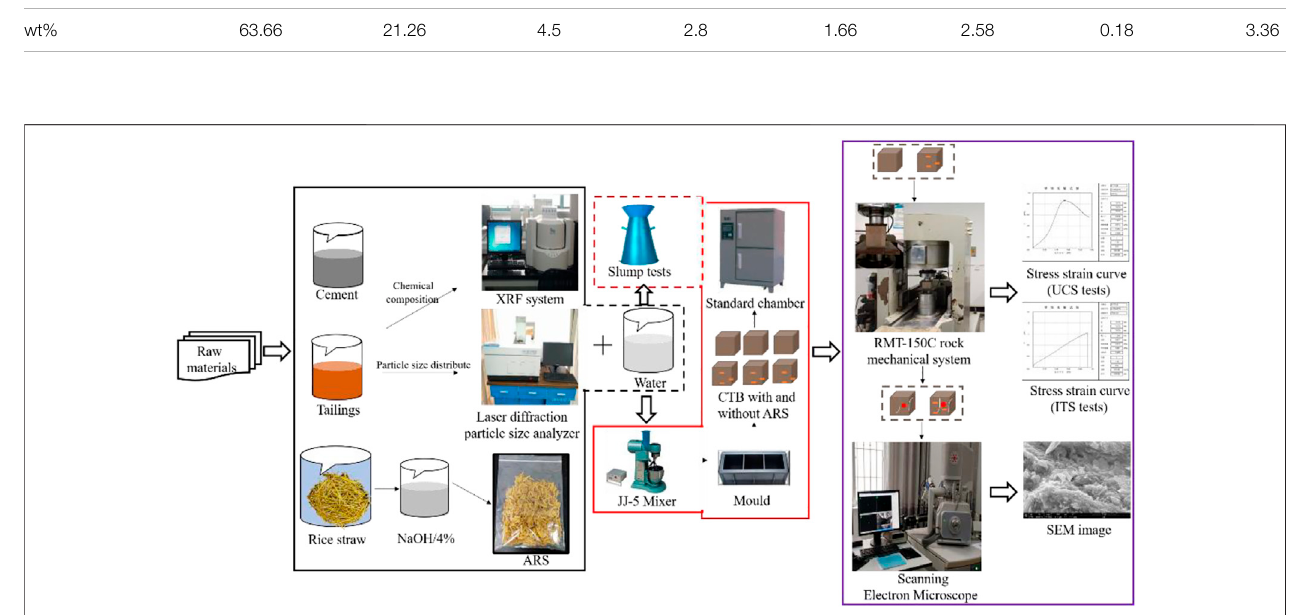
FIGURE 2 | The experimental fl owchart.